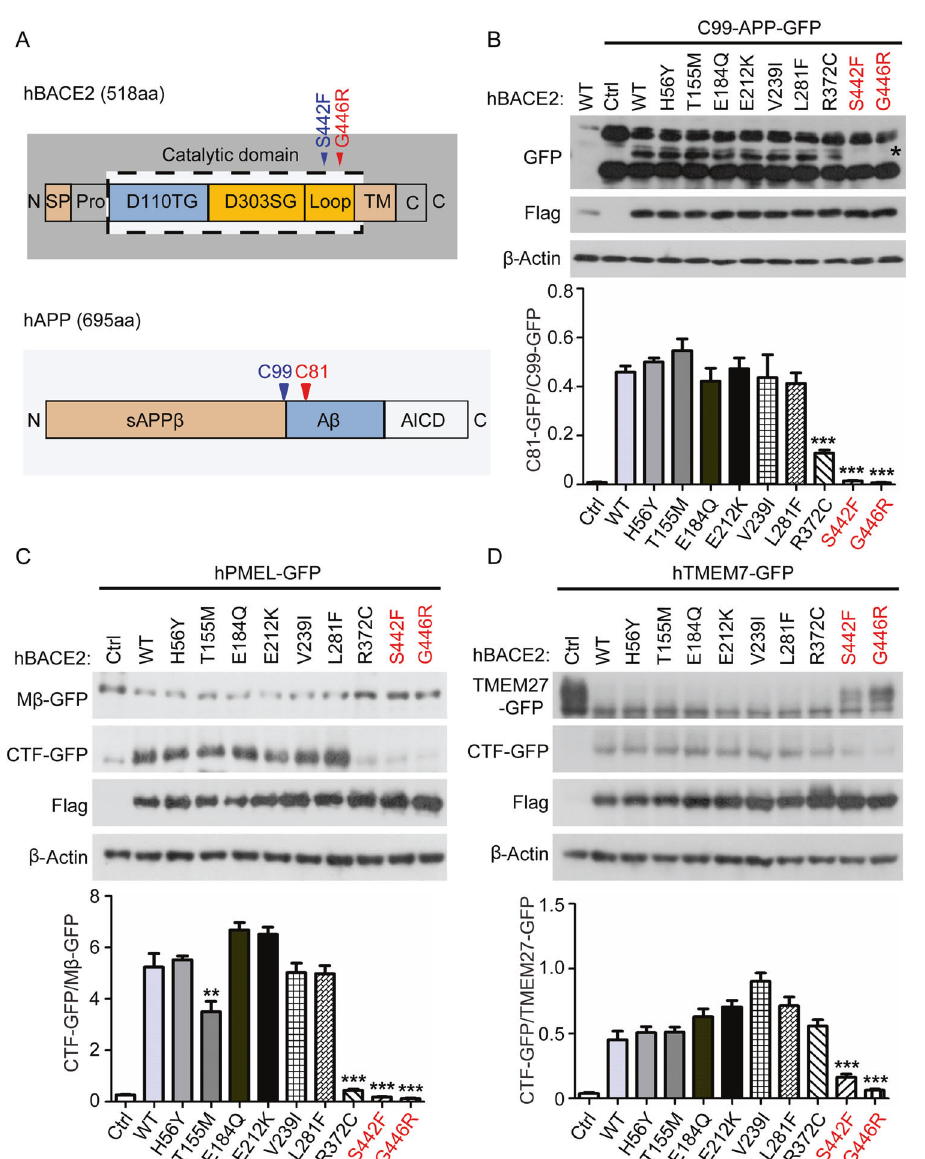
Fig. 1 HSCR-identi fi ed BACE2 variants are loss-of-function mutations. A hBACE2 protein domain map with S442F and G446R mutations indicated, and hAPP protein domain map with C99 and C81 sites indicated. B – D Western blot analysis of the BACE2 enzymatic activity carrying the HSCR-identi fi ed variants according to the substrate-based cleavage ef fi ciency, including C99-APP, hPMEL, and hTMEM7. The quanti fi cation data are shown as the mean ± S.D ( n = 3). Statistically signi fi cant differences are